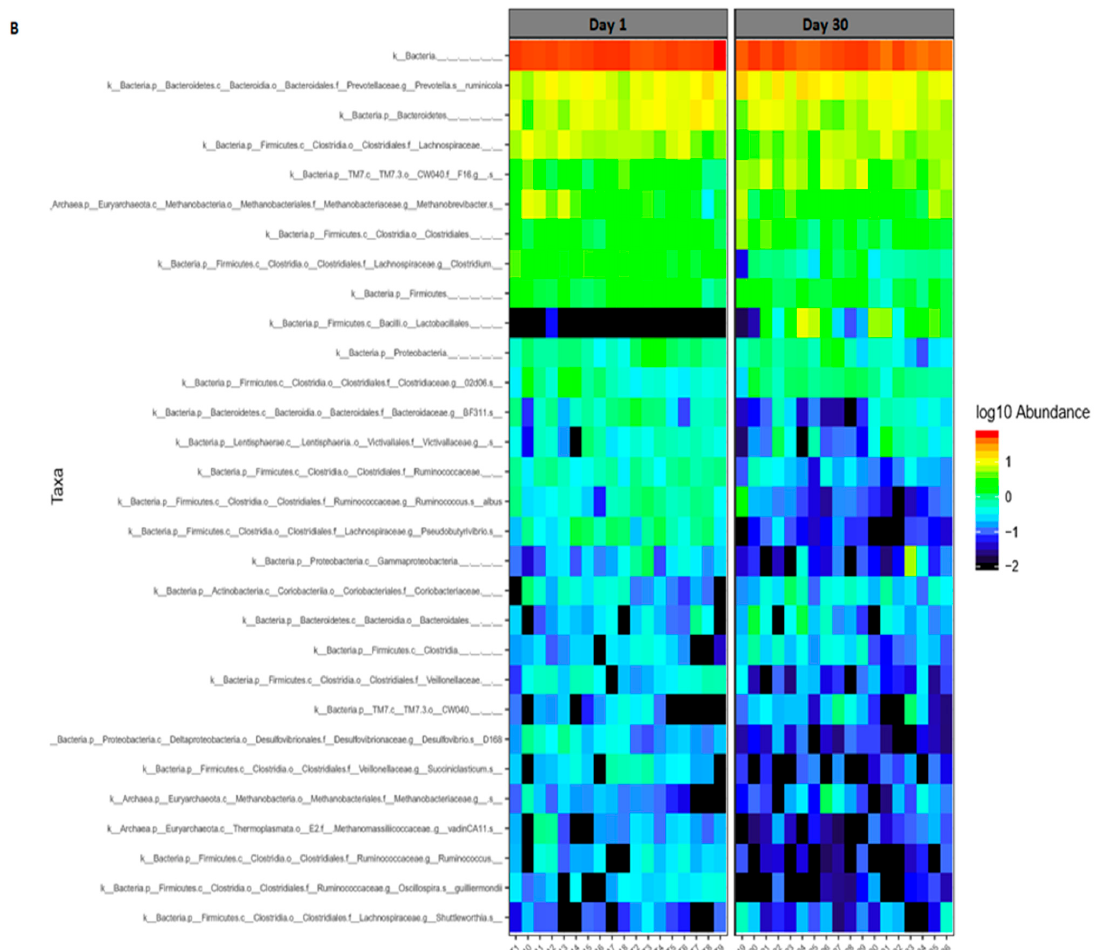
Figure 1. Relative abundance of bacterial and archaeal taxonomic classification between two goat breeds ( A ). Comparison of top 30 most abundant taxa between day 1 and day 30 of the trial ( B ). T1-T18 indicate samples collected at the beginning of the trial and T19-T36 was collected at the end of the trial. Relative abundance values for each taxonomic classification is illustrated by color intensity according to the legend provided on the scale of − 2 to 1.